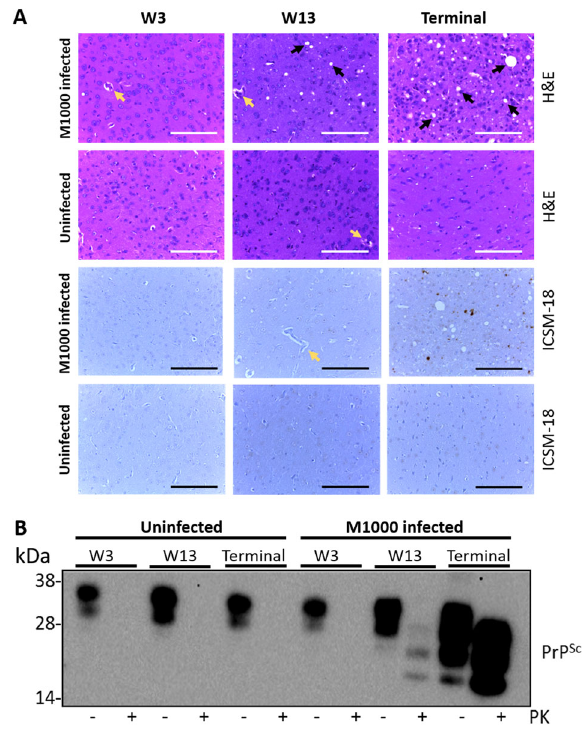
Fig. 1 Pathology associated with prion M1000 infected mice. A Histology was performed using haematoxylin and eosin staining and ICSM-18 on thalamus brain sections of uninfected and prion-infected M1000 infected mice prepared at week 3 (W3), week 13 (W13), and when the mice manifested clinical signs of prion disease (terminal stage). Black arrows indicate prion-associated spongiform changes. Yellow arrows are present to differentiate from other features such as blood vessels. Images are taken at ×40 magni fi cation. The scale bars shown are 100 μ m. B The detection of PrP Sc by Western blotting analysis of thalamus brain sections of uninfected and prion M1000 infected mice treated with proteinase K (PK, 100 μ g/ml Proteinase K and 0.05% SDS for 1 h at 37 °C). Representative images of n = 4 – 5 per